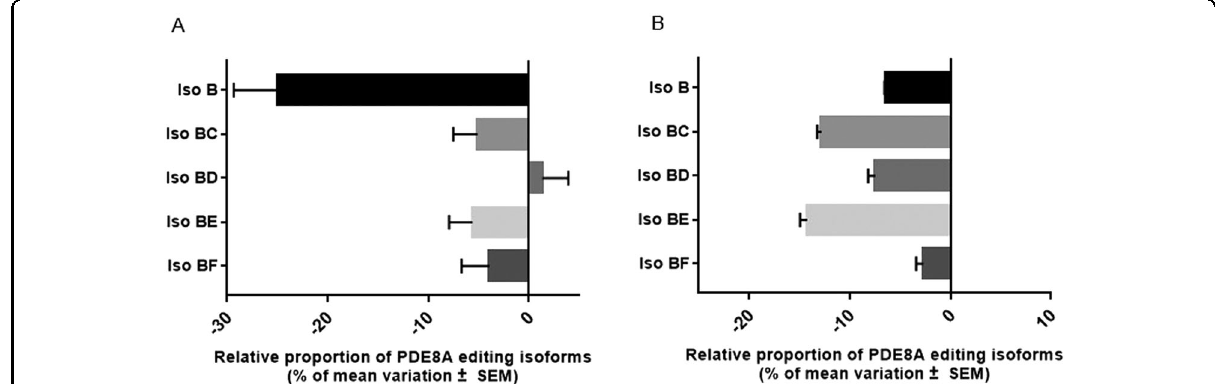
Fig. 4 Comparison of modi fi cations in PDE8A common isoforms between brain of suicide decedents and blood of suicide attempters. A Mean variation (mean± S.E.M.) of PDE8A editing isoforms in the brain (Dorsolateral prefrontal cortex, BA24) between suicide decedents suffering major depressive disorder ( n = 8) vs. healthy controls ( n = 8). B Mean variation (mean ± S.E.M.) of PDE8A editing isoforms in the blood of suicide attempters ( n = 76) vs. healthy controls ( n = 99).